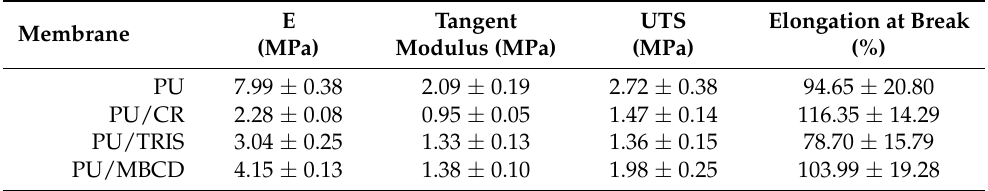
Table 2. Mechanical properties (Young’s modulus, tangent modulus, UTS and elongation at break) of the pure polyurethane and polyurethane blend membranes, obtained from the tensile